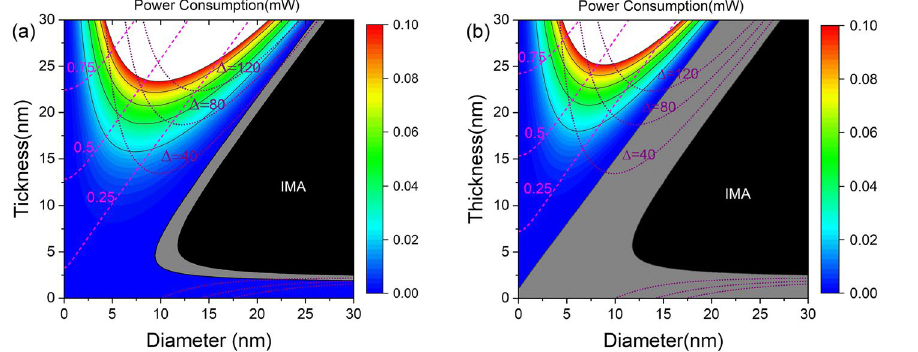
Figure 6. J STT,c and power consumption by STT as a function of thickness and diameter for J SOT = 1.0 × 10 12 A/m 2 ( a ) and J SOT = 6.0 × 10 12 A/m 2 ( b ), where the power consumption is obtained at critical switching current. The magenta dashed line and purple dotted line indicate J STT,c ( 10 12 A/m 2 ) and thermal stability,